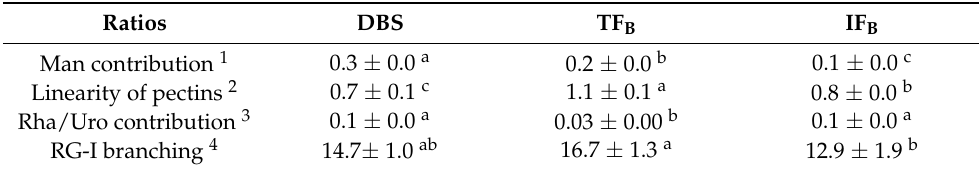
Table 3. Sugar ratios for characterisation of pectin and hemicellulose from different samples obtained from broccoli stalk